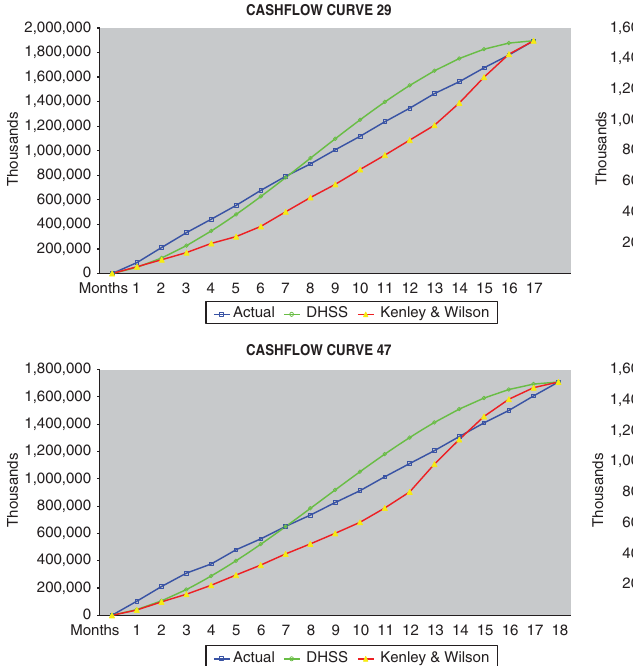
Fig. 2. Cash fl ow curves for projects 29, 46, 47 and 50